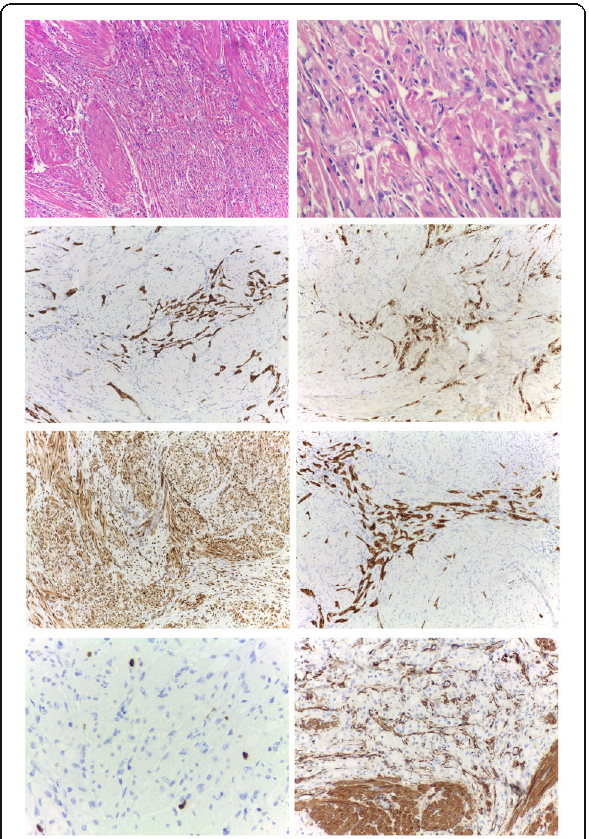
Fig. 1 First case of leiomyoadenomatoid tumor. The HE staining showed an adenomatoid component intermixed with prominent smooth-muscle proliferation (10x). Immunohistochemical study showed positivity for Calretinin, D2 – 40, WT1, CK7, and SMA, and negative results for CD34 and CD31 (10x)